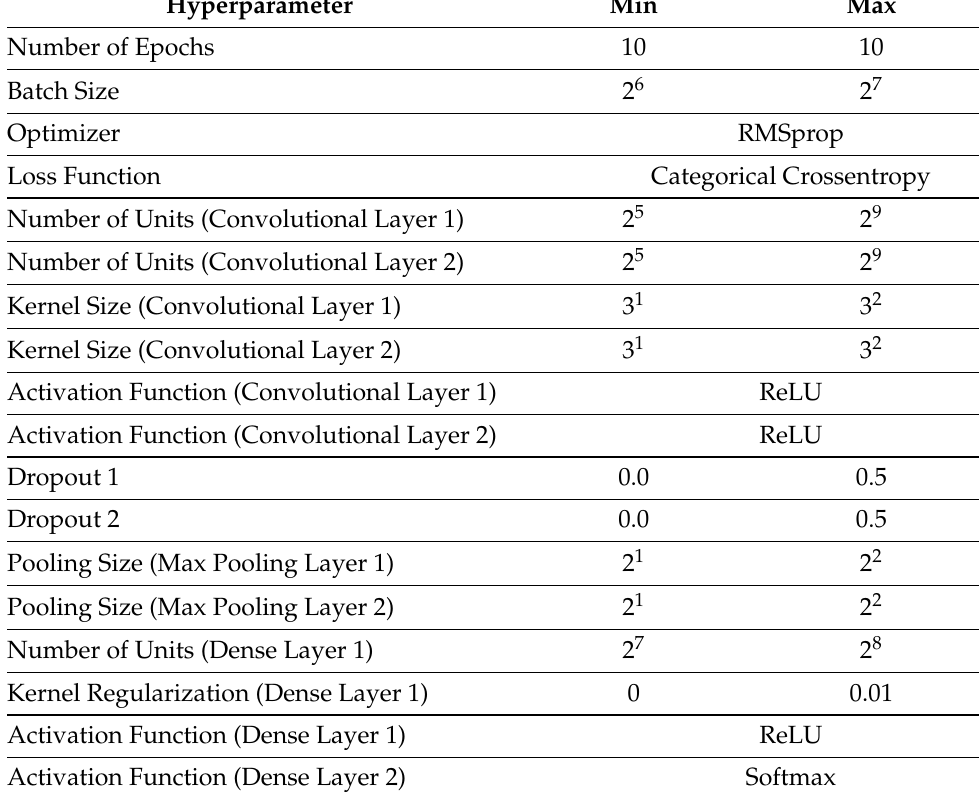
Table 8. Evaluated hyperparameters of the CNN architecture.